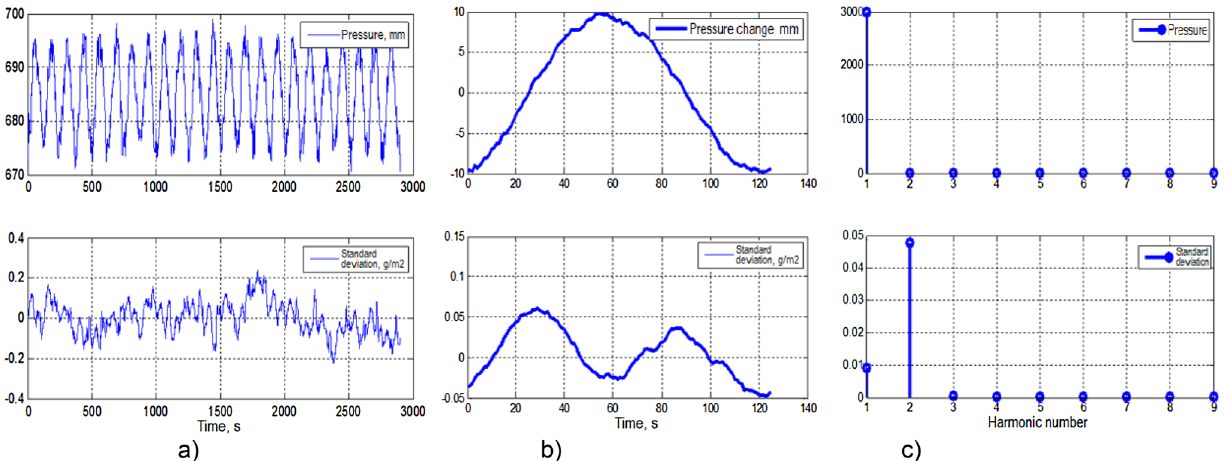
chronous accumulation of input and output signals; (c) results of harmonic analysis of input and output signals